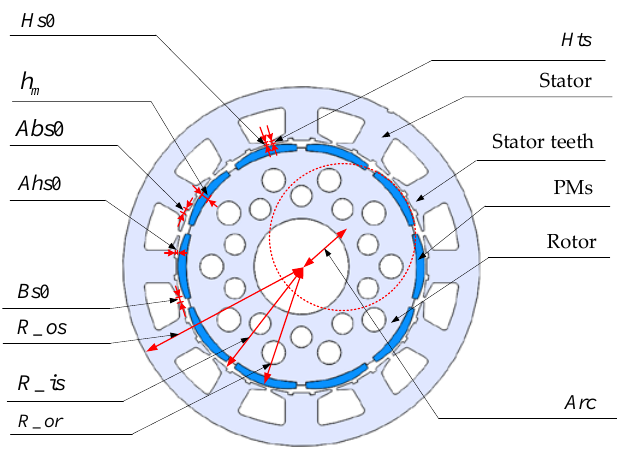
Figure 7. The structure of the PMSM. Table 1. Fixed parameters of the permanent magnet synchronous motor (PMSM).